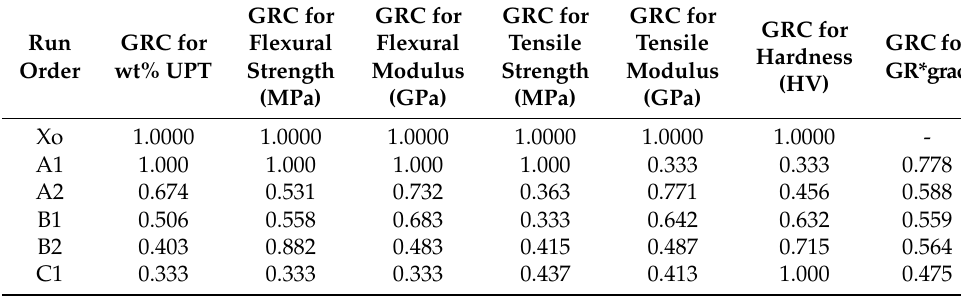
Table 4. Results of GRC and for GR*grade for mono-reinforced composites.